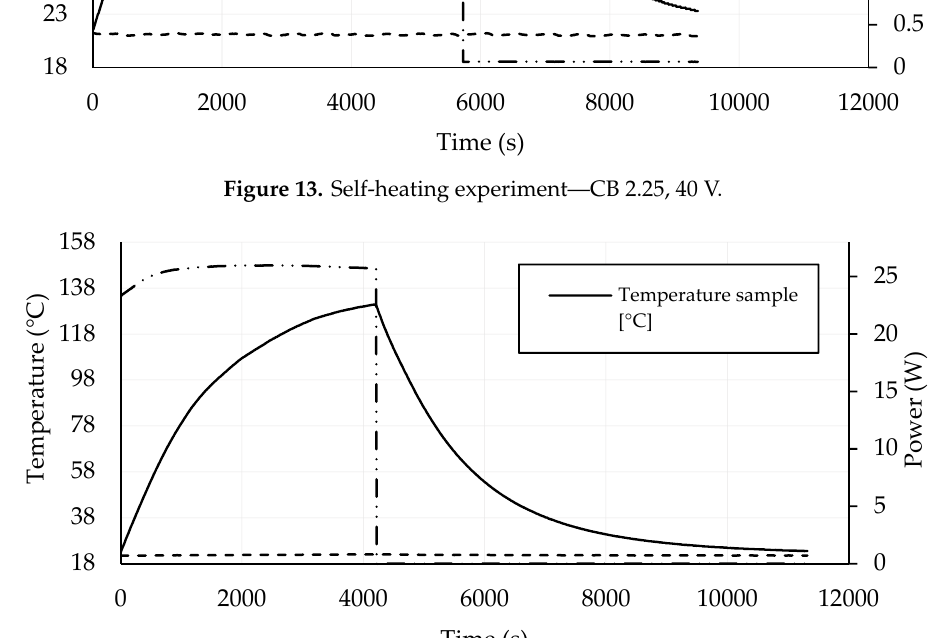
Figure 14. Self-heating experiment—CB 2.25, 100 V.